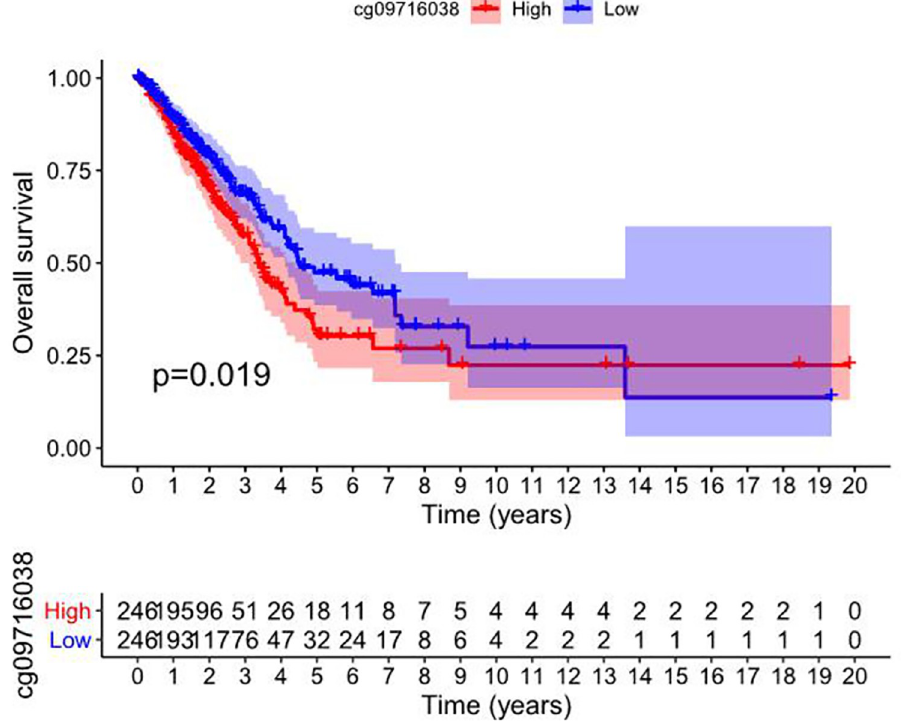
Fig 5. Survival analysis of high and low methylation level of cg09716038 related to RIOX2 gene in lung adenocarcinoma. The abscissa represents the survival time, and the ordinate represents the overall survival. Red represents the high methylation level of the gene site and blue represents the low methylation level of the gene site.